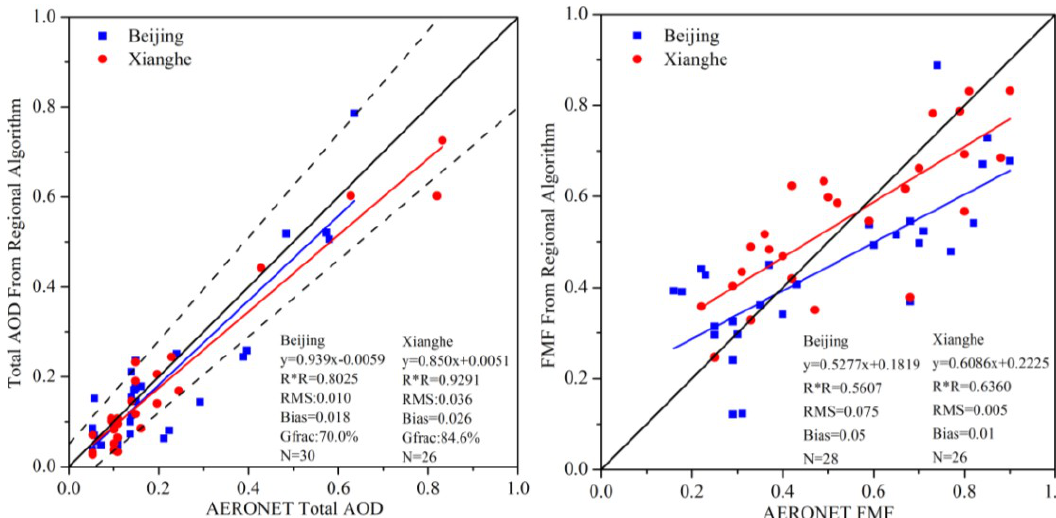
Fig.6. Comparison of Total AOD and FMF retrieved present regional algorithm with those of AERONET observations at Beijing and Xianghe from September to December in 2010.